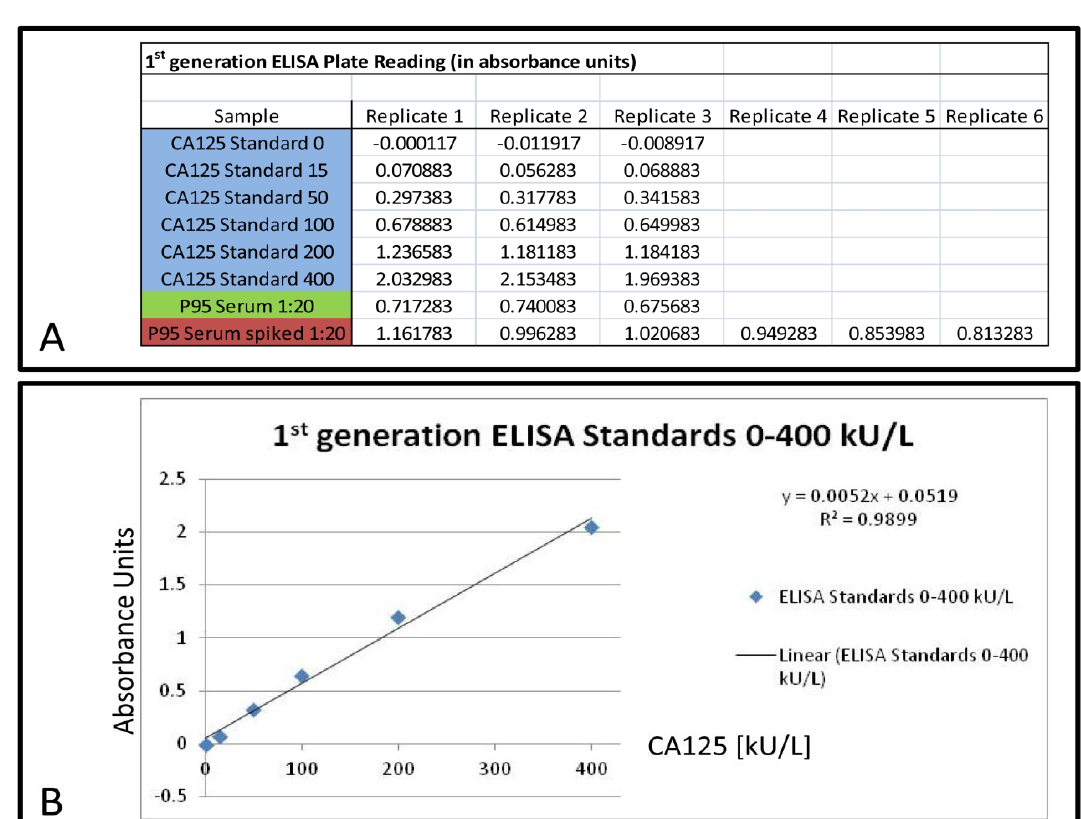
Figure 3. ( A ) Measured values in absorbance units for CA125 standards (0–400 kU/L) (blue), 1:20 diluted P95 serum (green) and 1:20 diluted P95 serum spiked with 80 µg fibronectin (red). The values obtained from P95 serum and spiked P95 serum were used for the Mann-Whitney U test; ( B ) Standard curve obtained by plotting the detected absorbance units against the kU/L of the CA125 standards. This curve was used to calculate the CA125 concentration of the used samples (C) CA125 concentration measured by a first generation ELISA (M11-like). Green: P95 serum, red: P95 serum spiked with 80 µg fibronectin. The increase in reading is statistically significant (* p < 0.05). Error bars indicate standard deviation of measured values within the respective sample; ( D ) CA125 concentrations measured by a clinically used second generation ELISA. I: 500 µL P607 serum + 100 µL H O; II: 500 µL P607 serum + 100 µL apo-serotransferrin (100 mg/mL); III: 500 µL P607 2 serum + 100 µL holo-serotransferrin (100 mg/mL). The increase in the reading for CA125 is statistically significant (*) between apo-serotransferrin (II) and unspiked serum (I) and statistically highly significant (** p < 0.01) between holo-serotransferrin (III) and unspiked serum (I). Error bars indicate the standard deviation of the measured values in the respective